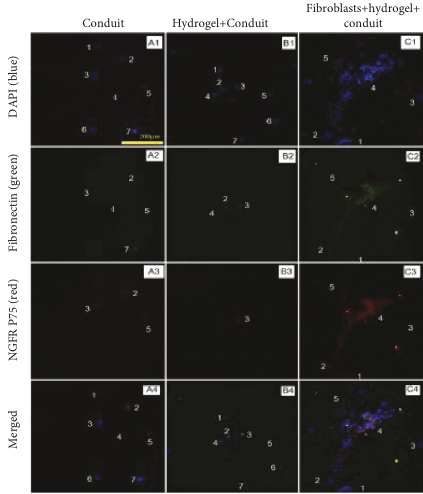
Figure 6: Immunofluorescence staining of Schwann cells and fi- broblasts on the 14th day of nerve repair.